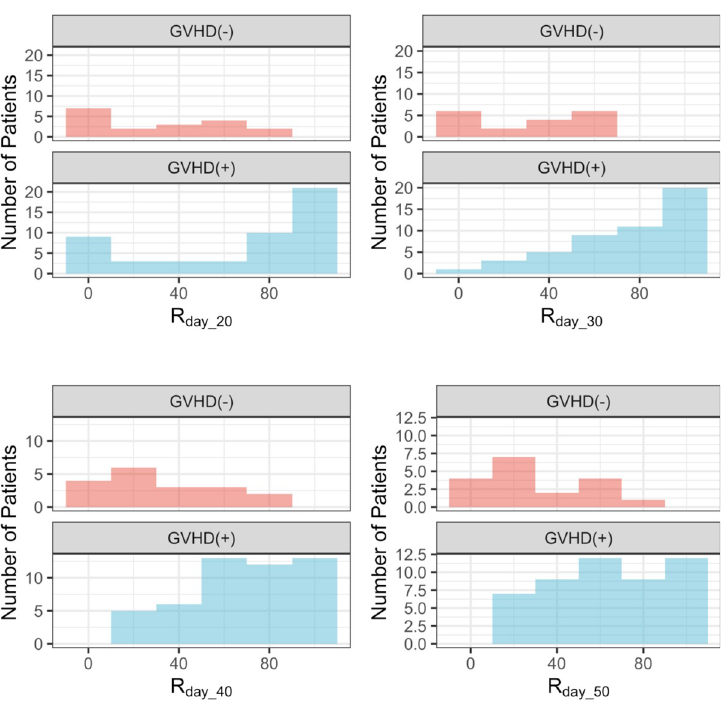
Fig 2. Distributions of R values for day n = 20, 30, 40, and 50. R day_n vertical axis is the number of patients, and the horizontal axis is the value of R day_n